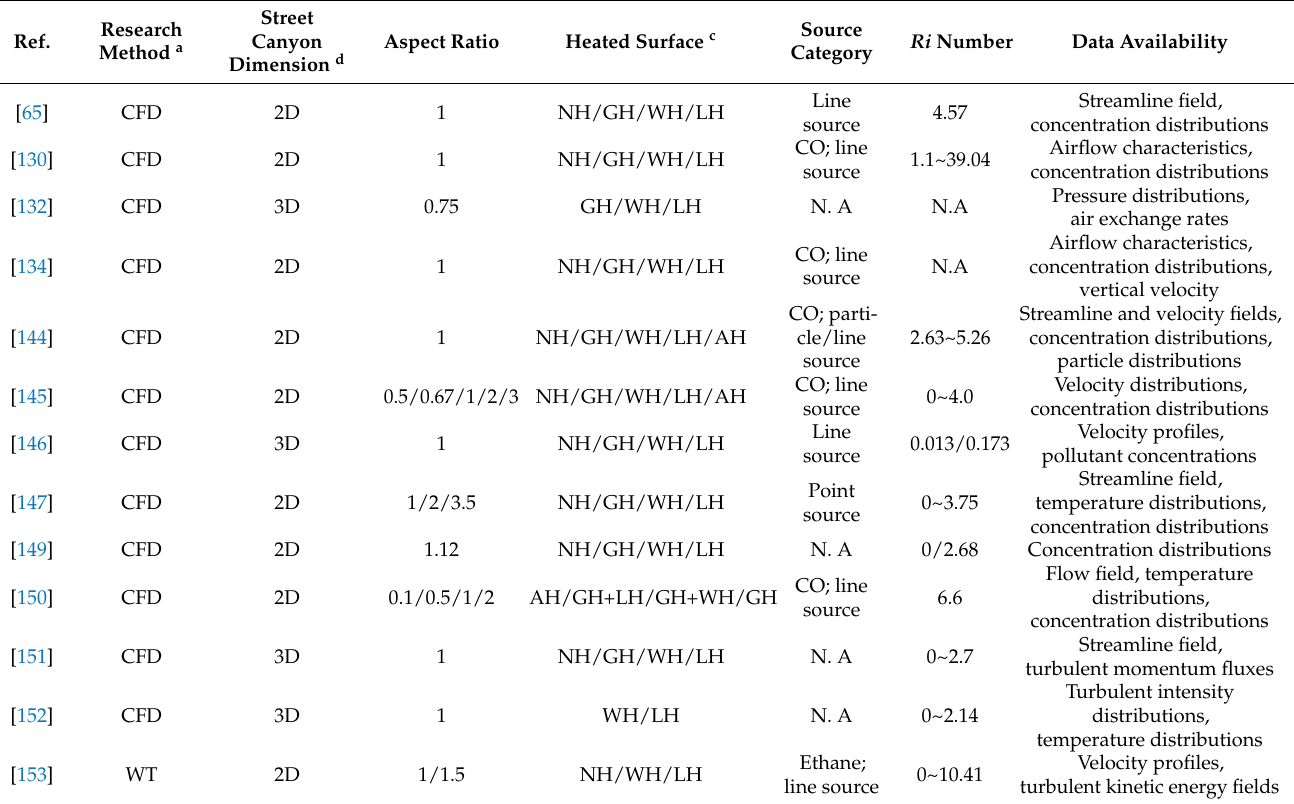
Table 3. Studies on thermal position under non-isothermal conditions in street canyons.